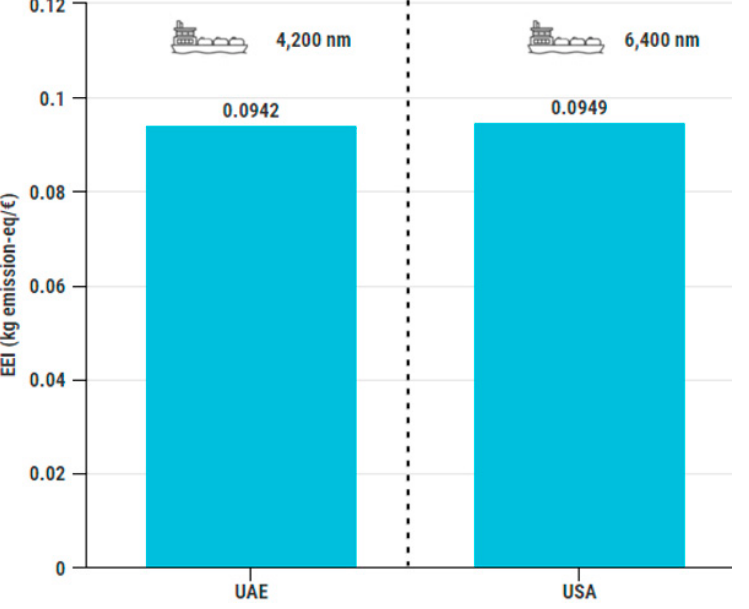
Figure 11. Impact of LNG distribution chains on EEI.